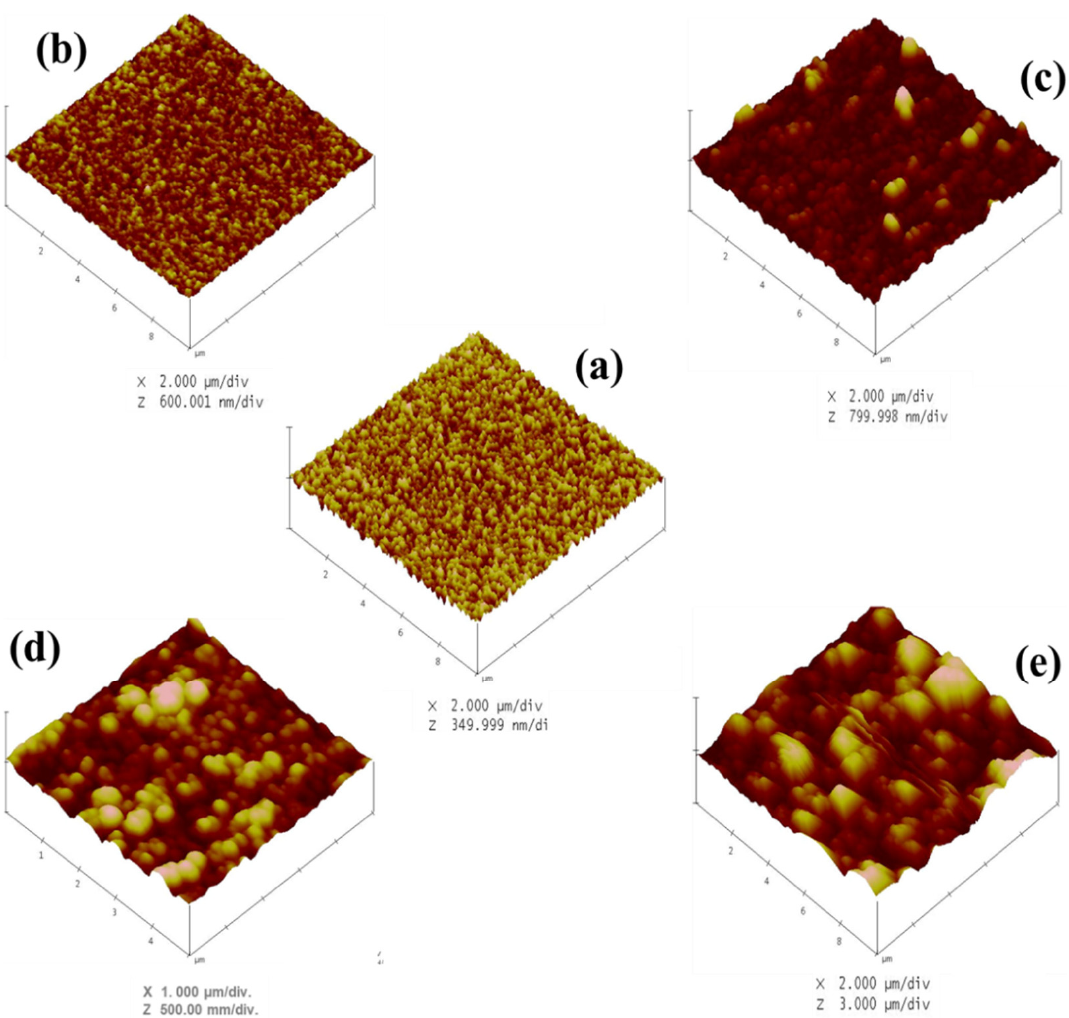
Figure 2. AFM images of TaN/Cu nanocomposite coatings with varying copper content (at.%): ( a ) 0, ( b ) 1.42, ( c ) 10, ( d ) 25.54 and ( e ) 35.